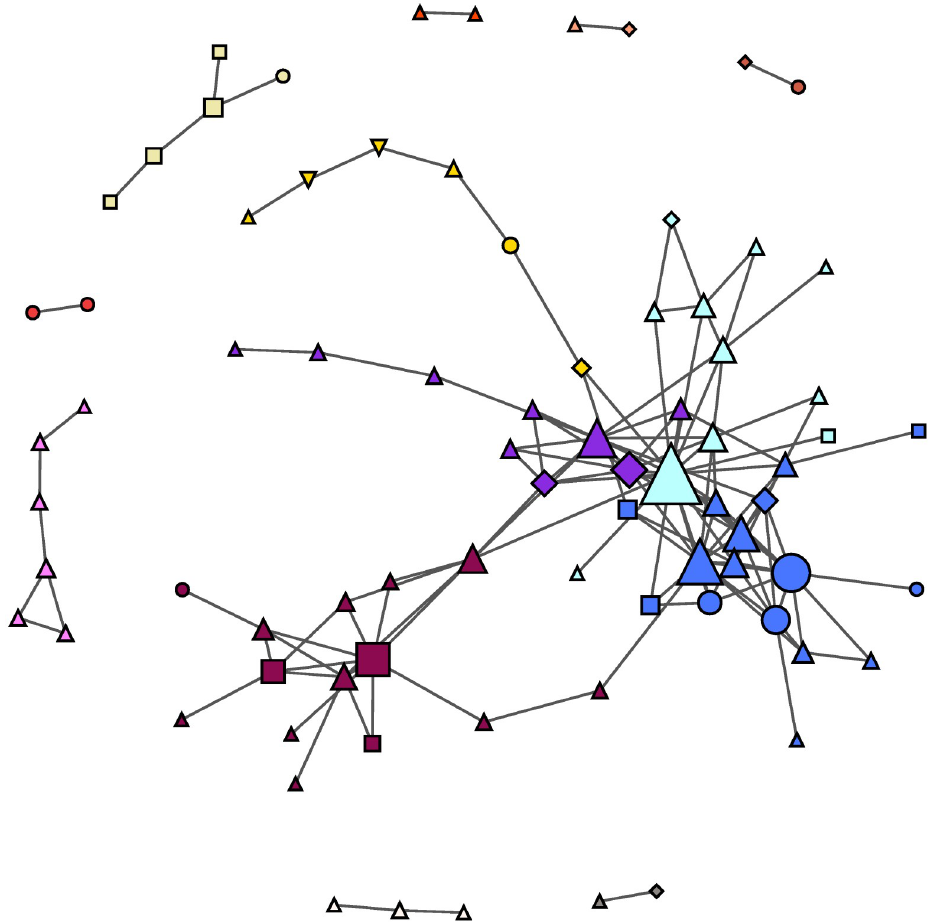
Fig 2. Validated projection of the network of firms. The network is composed by 80 firms and 135 links. The dimension of each node is proportional to its degree, i.e. the number of connections. The various colors represent the different communities. The shape of the nodes indicate the GUO (Global Ultimate Owner): rectangles are firms owned by the state or other public bodies, diamonds are firms owned by mutual & pension funds / nominal / trust funds, circles are firms owned by individuals or families (family firms), while triangles are companies; the rest are diamond